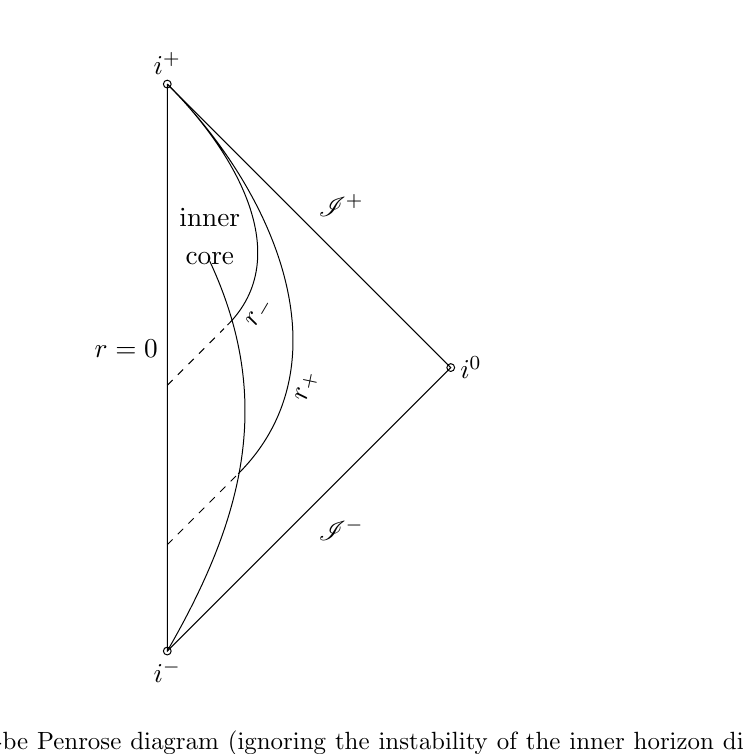
Figure 2 . The would-be Penrose diagram (ignoring the instability of the inner horizon discussed in section 3) for the formation and evaporation in an in(cid:12)nite time of a regular black